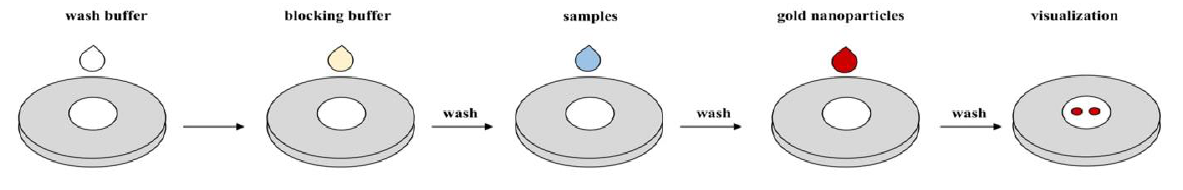
Figure 2. Commonly adopted protocol for vertical flow assays .